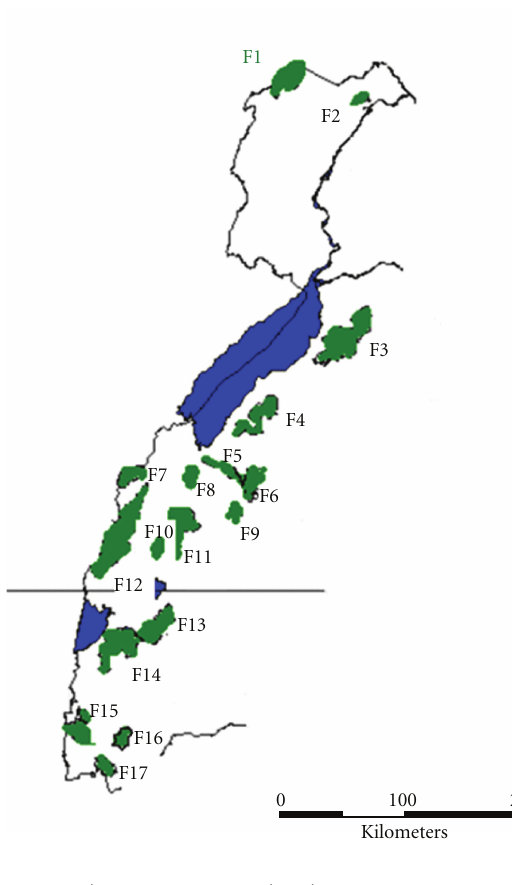
Figure 1: Location of the selected study forests in the Western Albertine Rift, Uganda.FR: Forest Reserve ; NP: National Park.